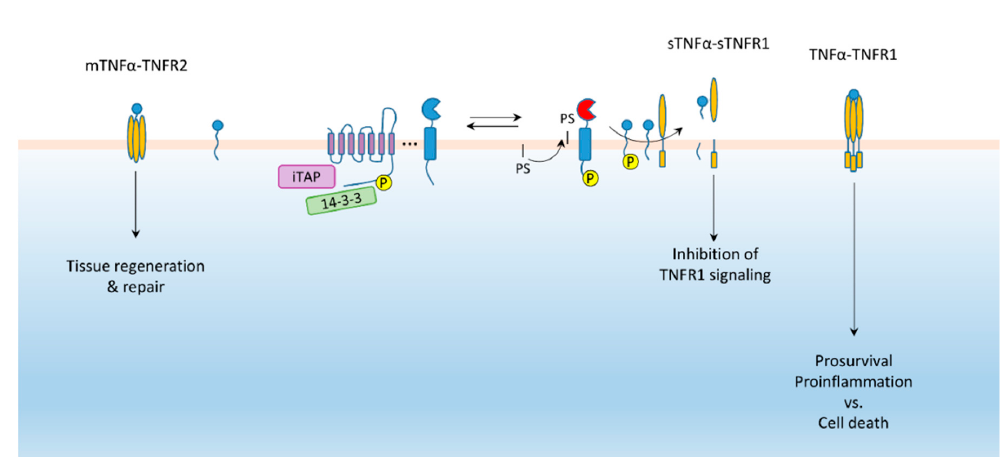
Figure 3. iRhom-ADAM17 regulation of TNF signaling. TNFR1 signaling depends on whether TNF α or TNFR1 is predominantly cleaved. In the absence of TNF α cleavage TNFR2 signaling is